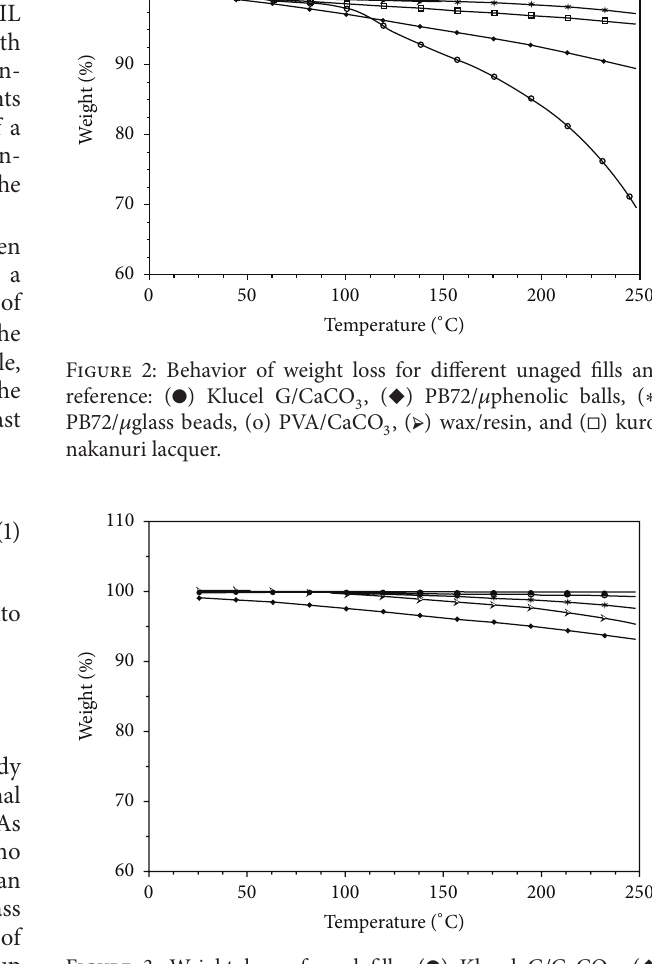
Figure 3: Weight loss of aged fills: ( e ) Klucel G/CaCO 3 , ( X ) PB72/ 𝜇 phenolic balls, (∗) PB72/ 𝜇 glass beads, (o) PVA/CaCO 3 , ( „ ) wax/resin, and (◻) kuro-nakanuri